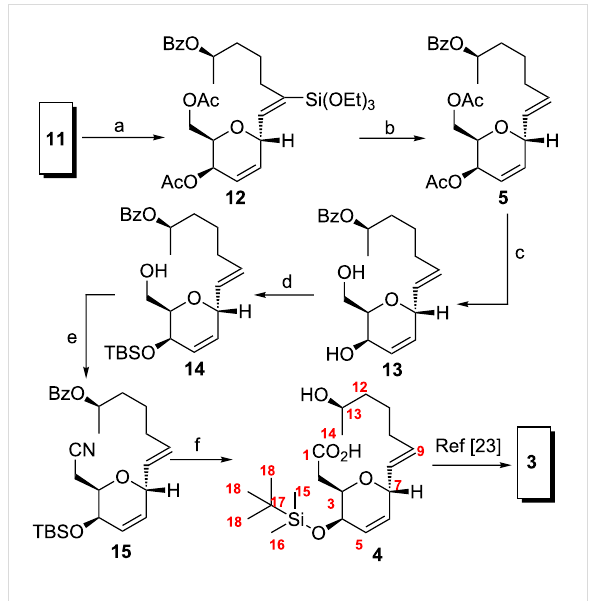
Scheme 3: Synthesis of 4 and formal total synthesis of ( − )-aspergillide C ( 3 ). Reaction conditions: (a) [Cp*(MeCN) 3 Ru]PF 6 , (EtO) 3